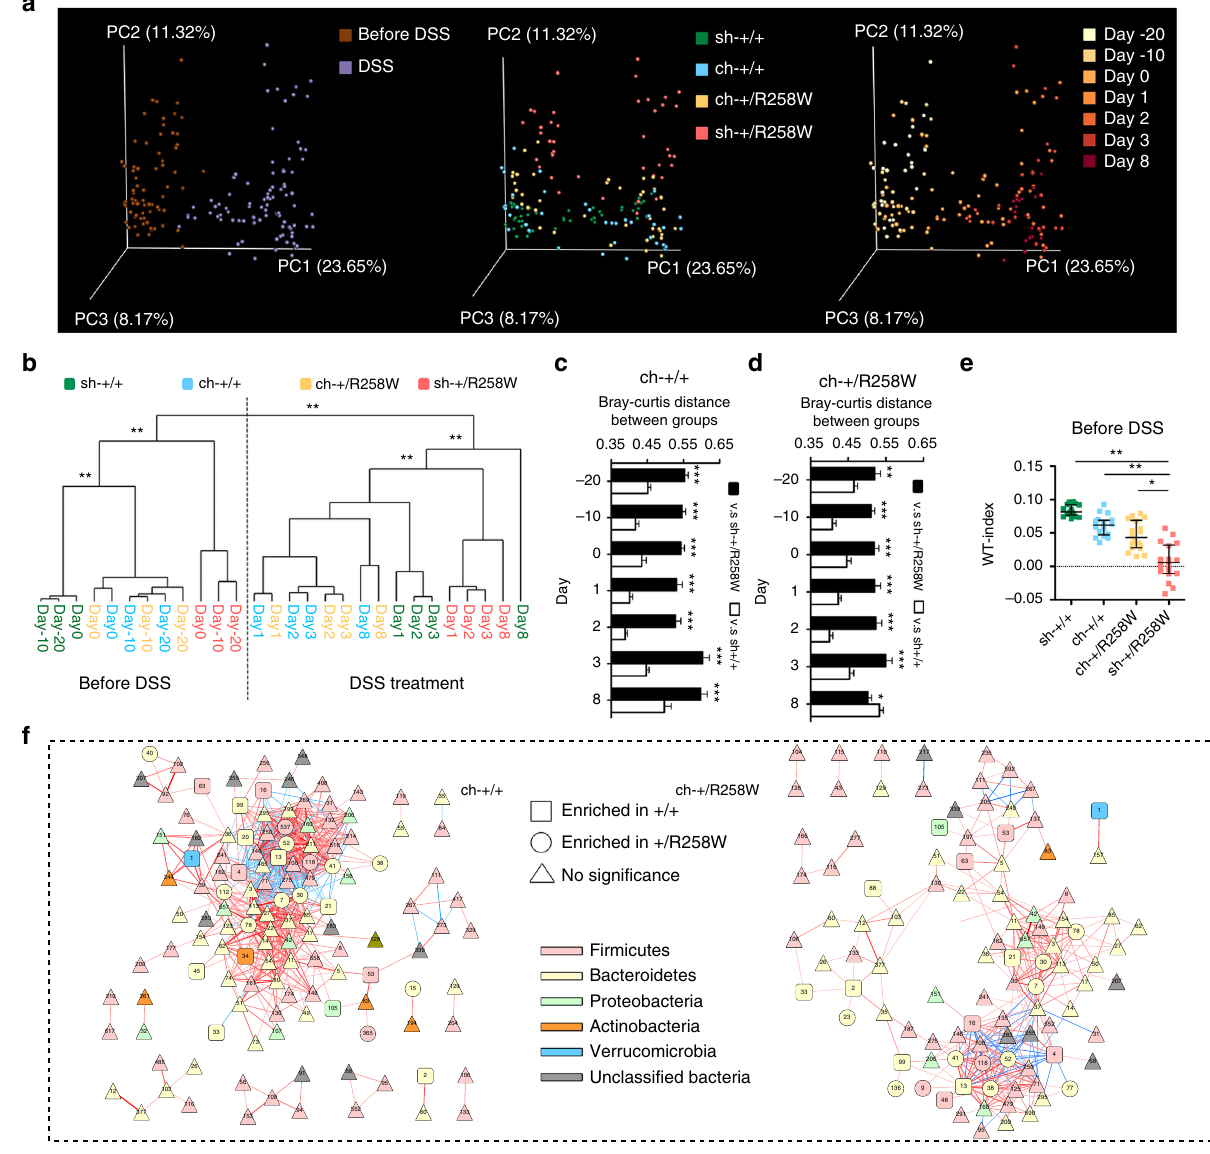
Fig. 4 The gut microbiota of the Nlrp3 R258W mice is affected by cohousing with WT littermates. a – f Fecal microbiota composition was assayed by bacterial 16S rRNA V3 – V4 region sequencing: a PCoA plot (based on Bray – Curtis distance) of the fecal microbiota of singly housed WT (sh-+/+), cohoused WT (ch-+/+), cohoused Nlrp3 R258W (ch-+/R258W), and singly housed Nlrp3 R258W (sh-+/R258W) mice ( n = 6 in each group) before and during DSS treatment. b Clustering of the gut microbiota based on distances between different groups with the fi rst 16 PCs (accounting for 80% of total variations) of the PCoA based on the Bray – Curtis distance. ** P < 0.01 (MANOVA test). ( c , d The Bray – Curtis distance of the ch-+/+ ( c ) and ch-+/R258W ( d ) gut microbiota to the sh-animals was calculated. The data are shown as means ± SEM. * P < 0.05, ** P < 0.01, *** P < 0.001 (two-tailed Student ’ s t test). e The WT indices of sh-+/+, ch-+/+, ch-+/R258W, and sh-+/R258W mice before DSS treatment: the medians with interquartile ranges are shown. * P < 0.05, ** P < 0.01 (Kruskal – Wallis test). f The network of OTUs (shared by more than 40% samples) in co-house WT mice and co-house Nlrp3 R258W mice during DSS treatment ( n = 6 from day − 20 to day 3 and n = 4 on day 8). The red lines represent positive correlations between the nodes and the blue lines represent negative correlations, with line width indicating the correlation magnitude. Only the | R | is greater than 0.7 are drawn, and unconnected nodes have been omitted (refer to Fig.